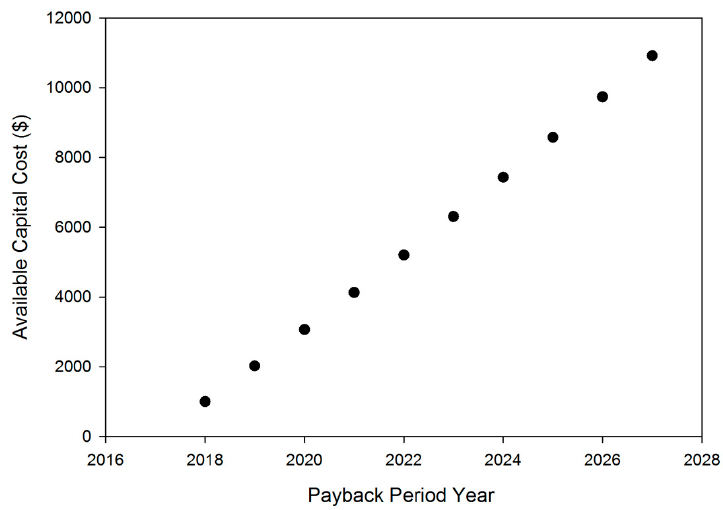
Figure 7. Monthly percentage of cost savings for each of the modeled buildings. Energies 2018 , 11 , x FOR PEER REVIEW